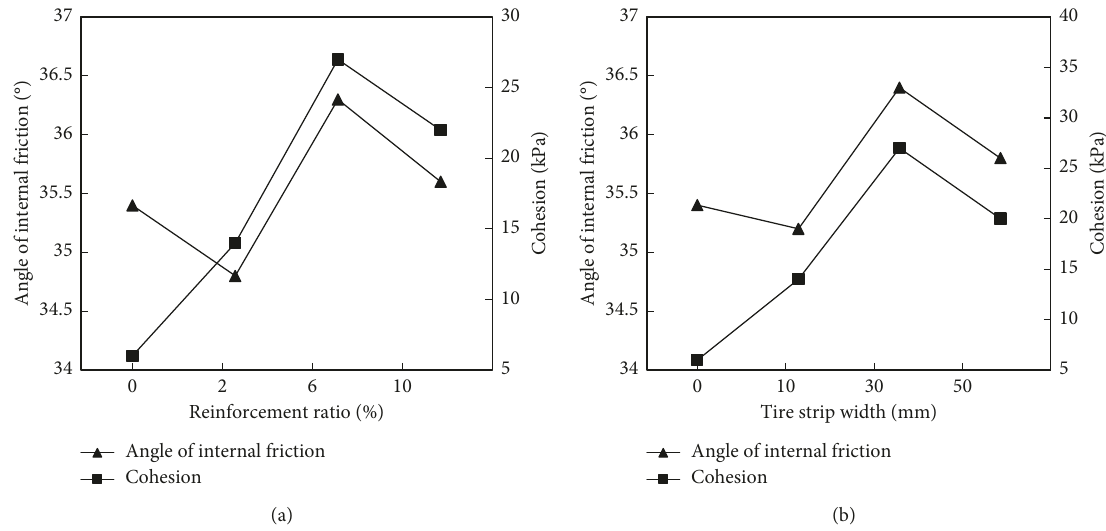
Figure 8: Shear strength relationship between reinforced rate and width of tire strip.